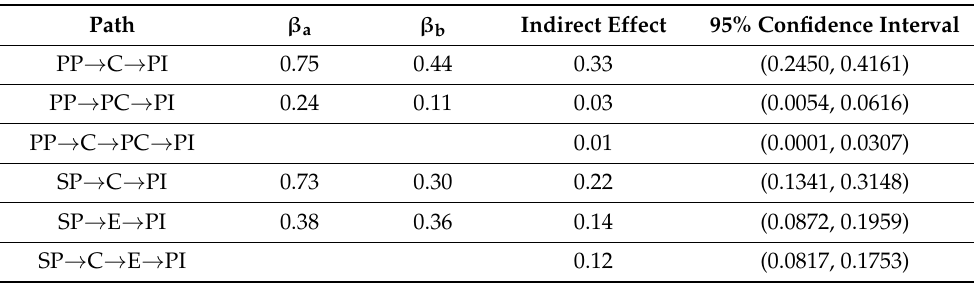
Table 8. Results on Indirect effect for different paths.